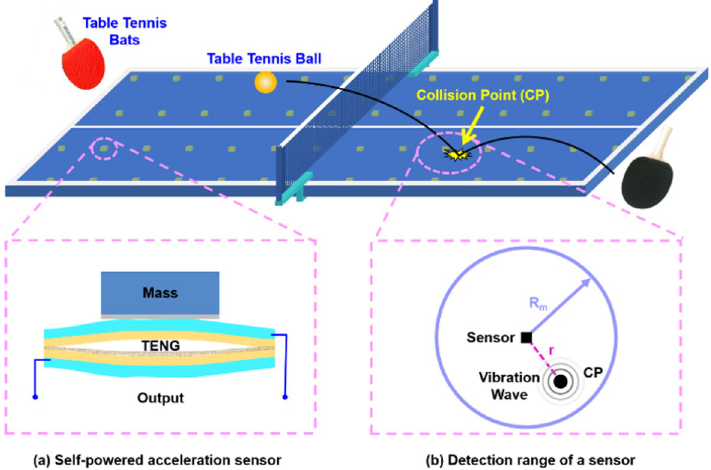
Fig 1. Schematic of the intelligent umpiring system by deploying the self-powered acceleration sensor on the back of the table. (a) Schematic of the self-powered acceleration sensor. (b) Detection range of a sensor with a maximum detection